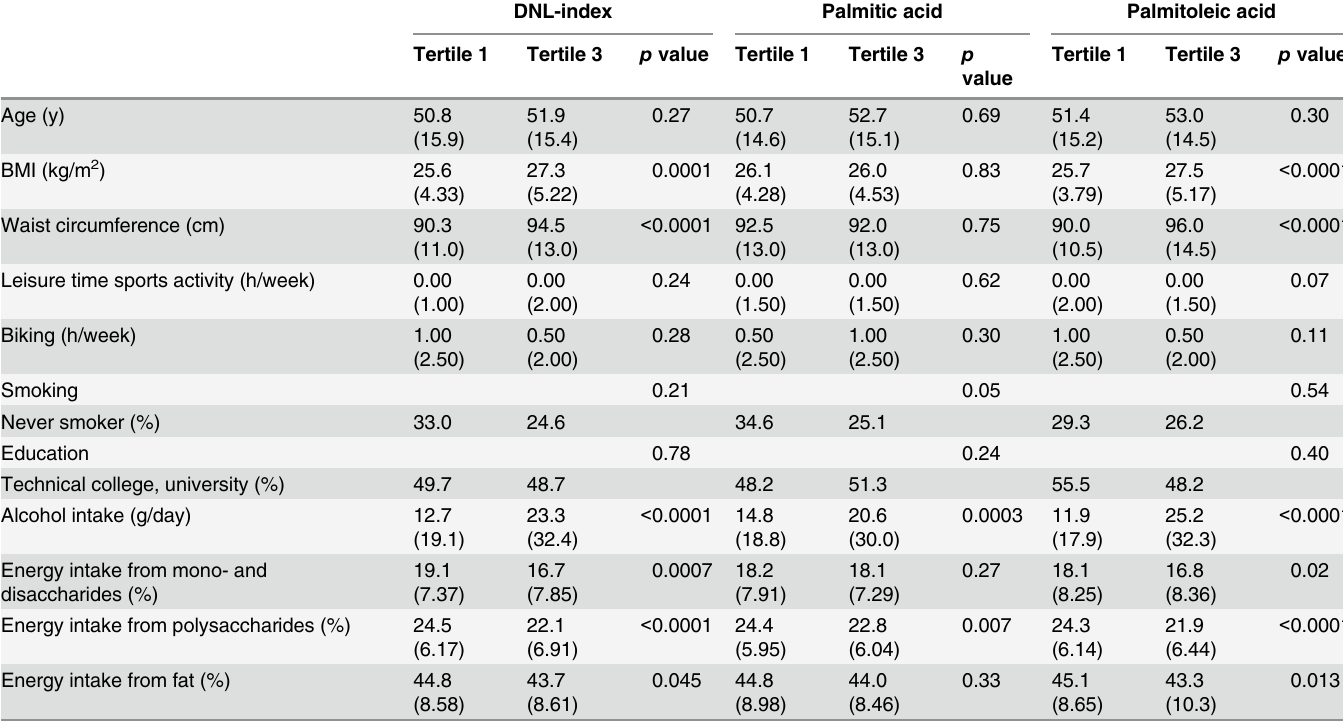
Table 1. Characteristics by tertiles of the DNL-index (16:0 / 18:2n-6), palmitic acid (16:0) and palmitoleic acid (16:1n-7) in men, EPIC-Potsdam study (n = 573) a